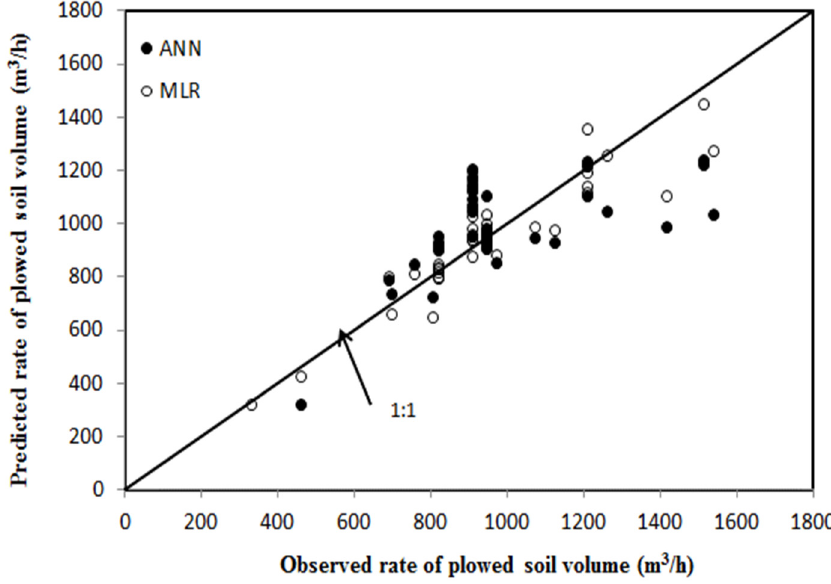
Figure 10. Correlations between the observed and predicted values for the rate of plowed soil volume of the ANN and MLR models in the case of the testing dataset.